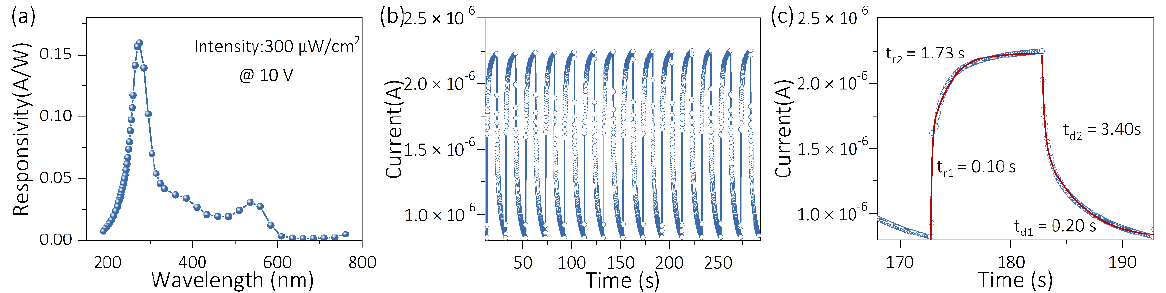
Figure 3. ( a ) Spectral response at 10 V bias; ( b ) transient light response curve; ( c ) amplification of single transient light response curve and time fitting.